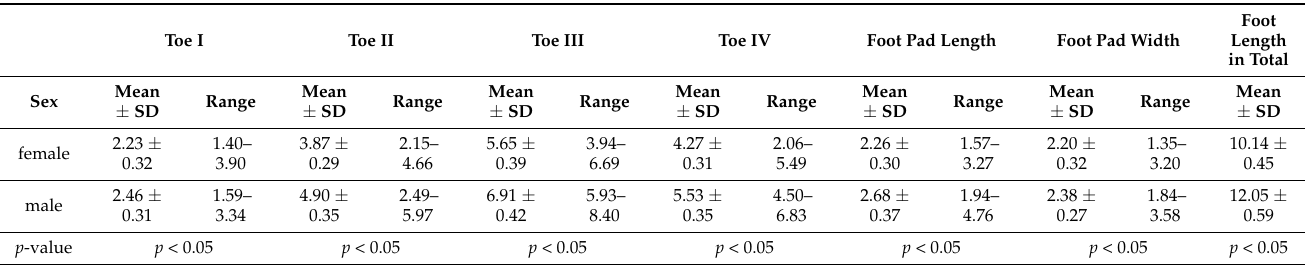
Table 2. Measurements (cm) at time of slaughter of toe I–IV and foot pads of female ( n = 506 feet) and male ( n = 150 feet) broiler breeders, as well as length and width and the foot length in total (toe I + foot pad length + toe III).